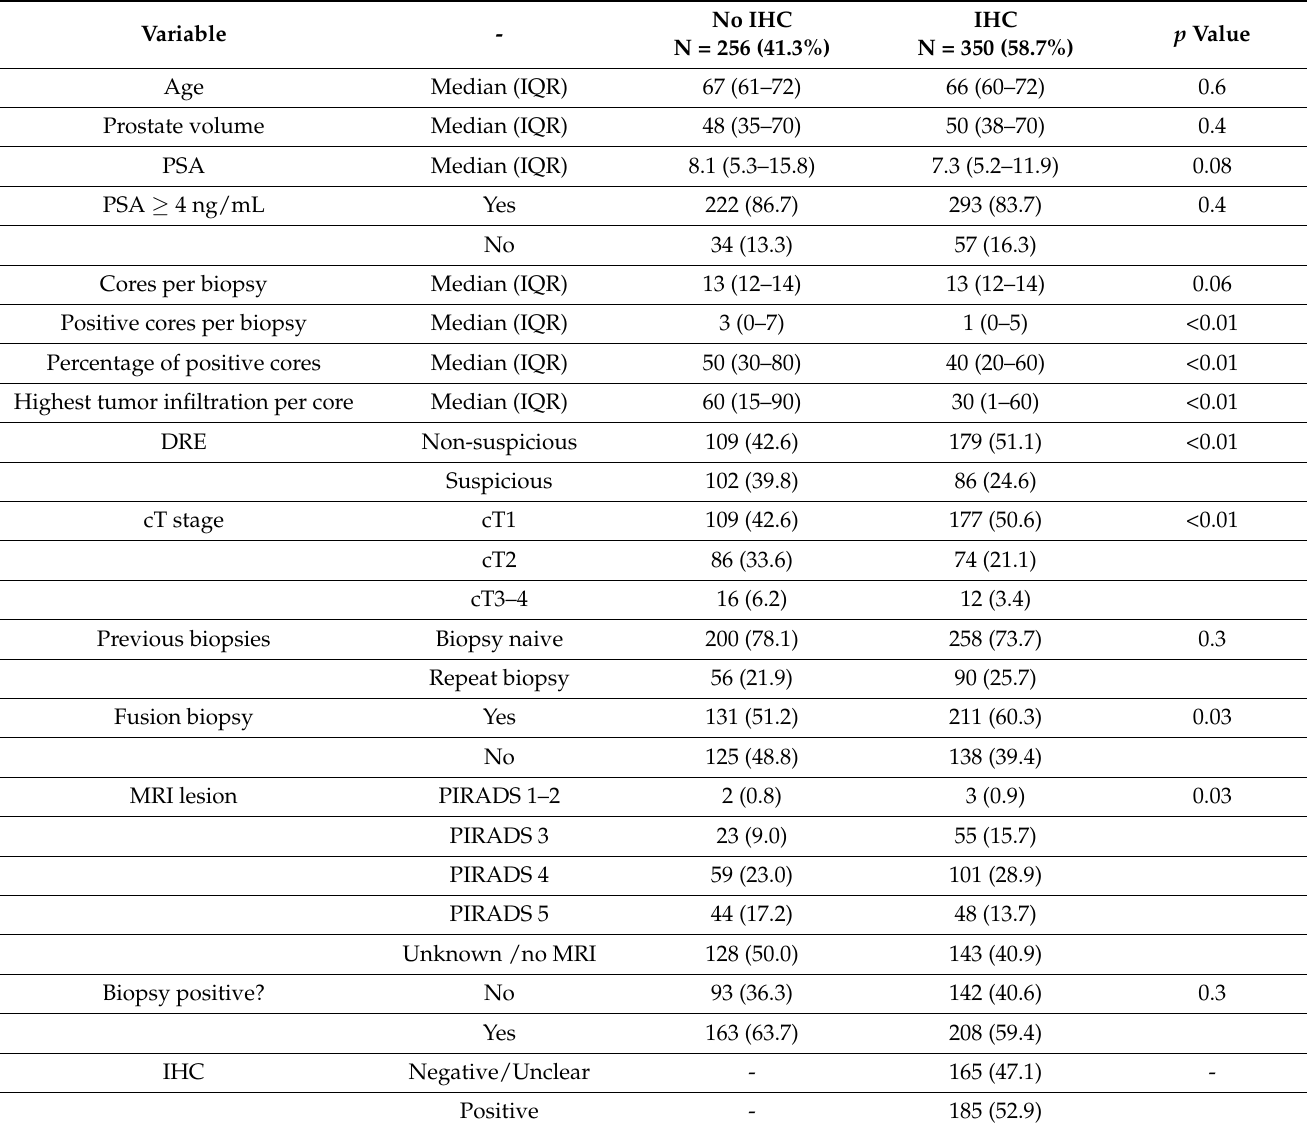
Table 1. Descriptive analyses of 606 patients who underwent prostate biopsy at University Hospital stratified according to the performance of immunohistochemistry (IHC). Abbreviations: PSA—prostate-specific antigen; DRE—digital rectal examination; GS—Gleason